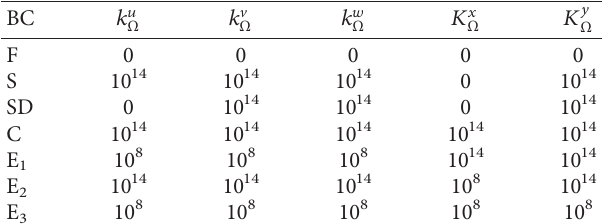
Table 2: Weight parameters of LCDPS under different